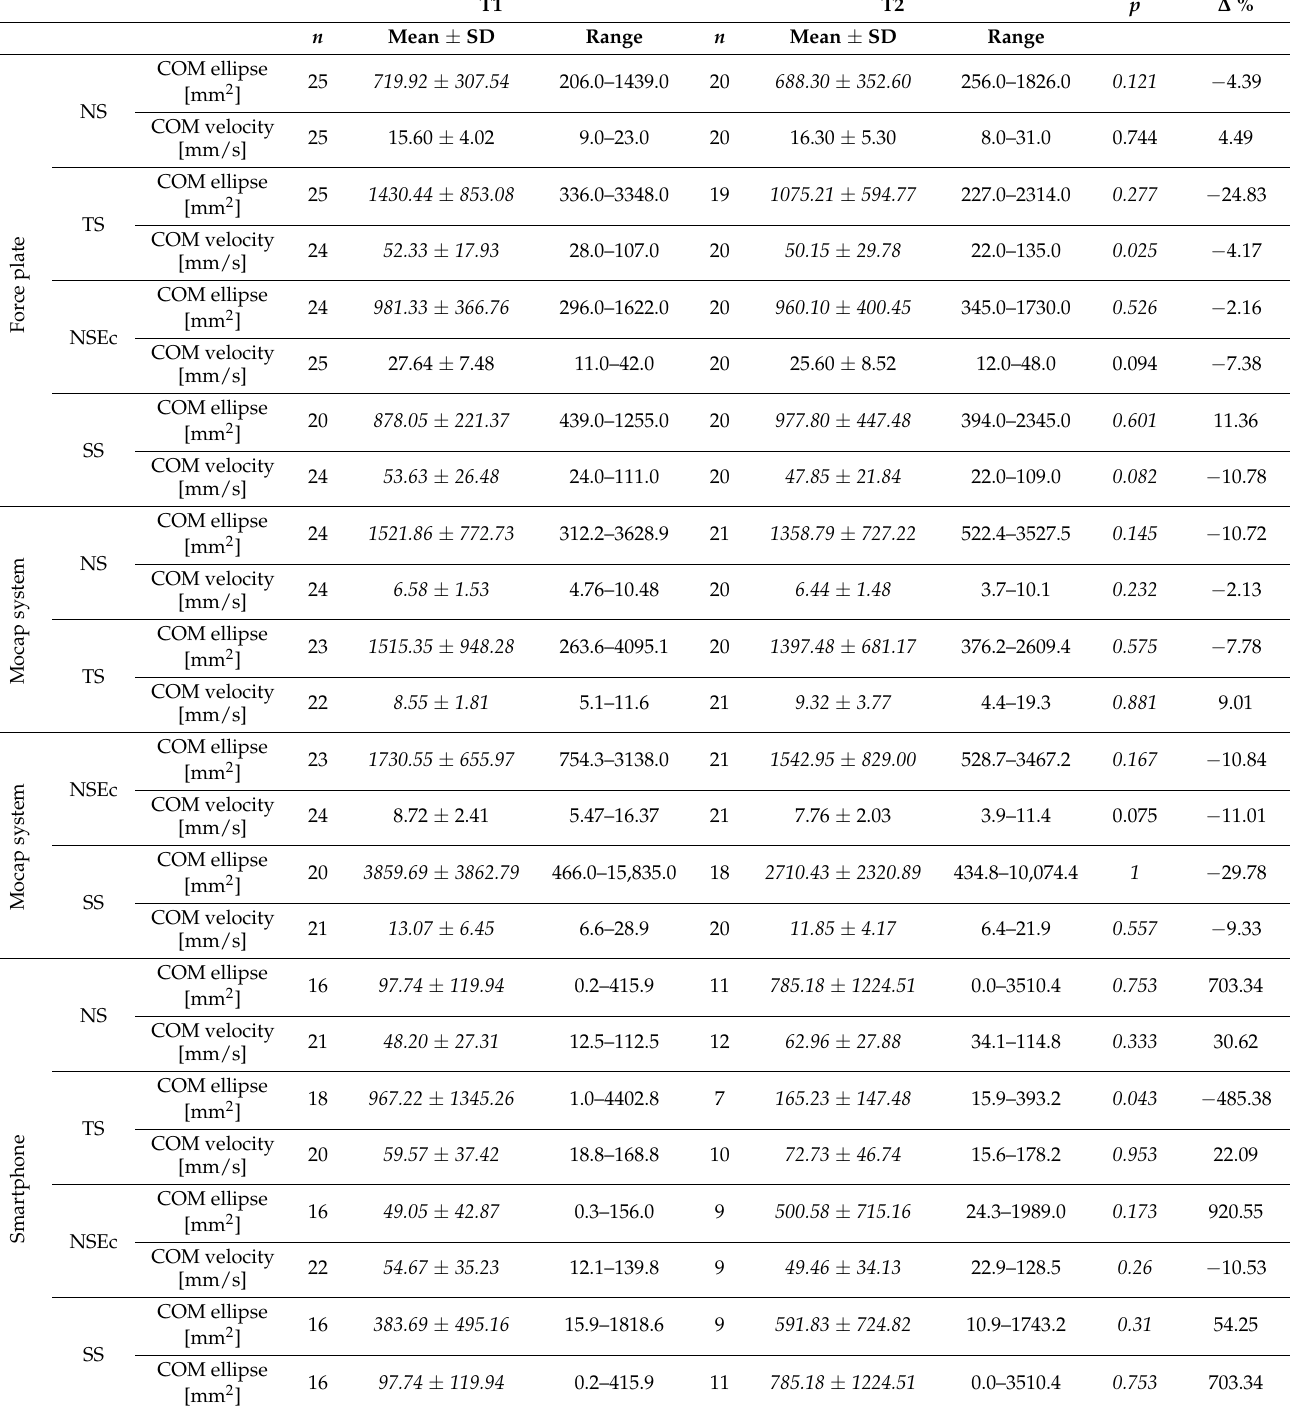
Table A2. Differences in mean between the first (T1) and second study visit (T2) for the balance variables of all three gait analysis systems. Bold font indicates a significant difference in time (T1-T2, p < 0.05) and italic font indicates a difference in time in the post-hoc test only ( p < 0.05). An asterisk marks all significant values in general. COM = center of mass, min. = minimum, max. = maximum, NS = narrow stance, NSEc = narrow stance with eyes closed, SD = standard deviation, SS = single leg stance, TS = tandem stance.